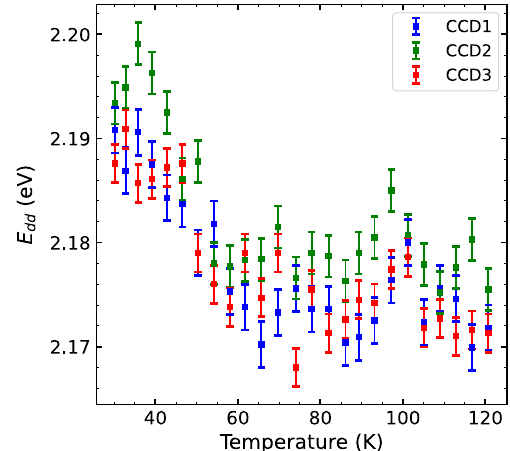
FIG. 8. Average energy and of the dd exciton peak of over- ¼ 70 K) for momentum (0.36, 0) doped Bi-2212 ( p ¼ 0 . 21 , T c measured with 3 different